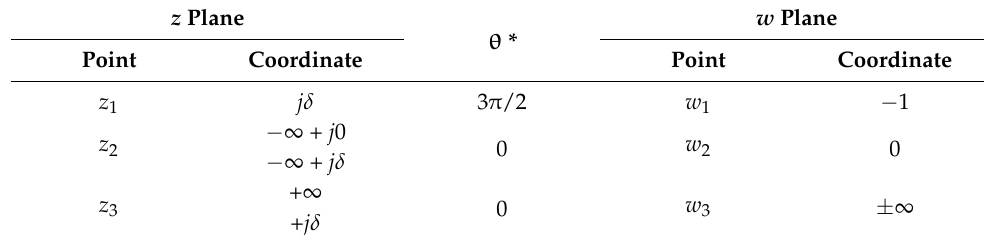
Table 2. SCT table of z plane and the w plane at the primary-side end. z Plane w Plane θ * Point Coordinate Point